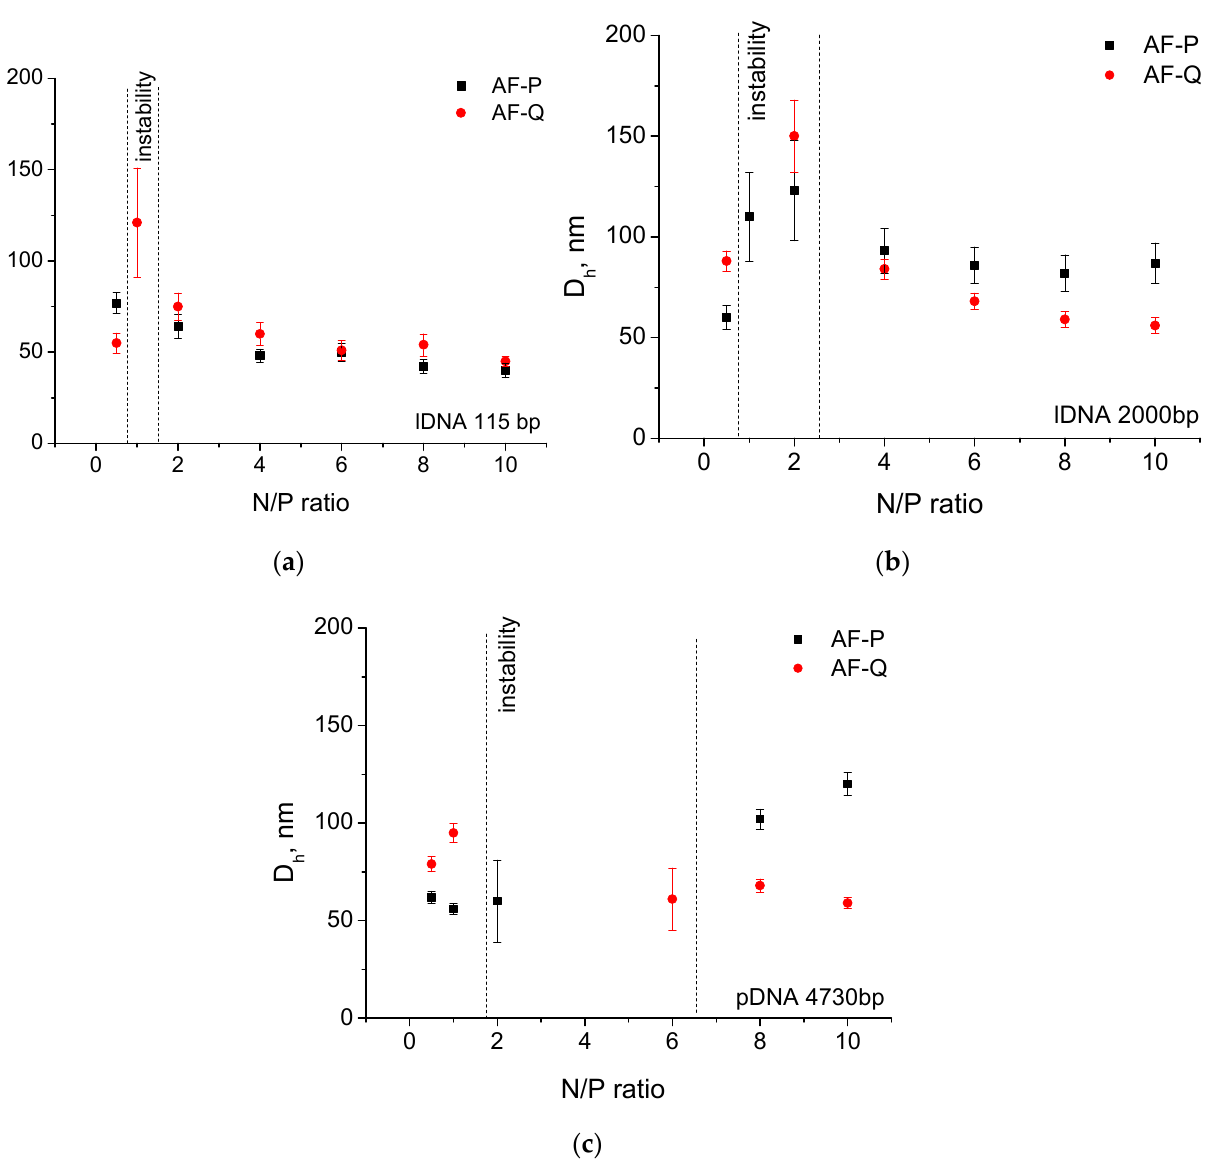
Figure 2. Variations of the hydrodynamic diameter, D h , with the N/P ratio of polyplexes based on PDMAEMA star-shaped polymers prepared with ( a ) lDNA 115, ( b ) lDNA 2000 and ( c ) pDNA 4730. Outside the instability area, colloidally stable, narrowly distributed (PDI in the 0.075–